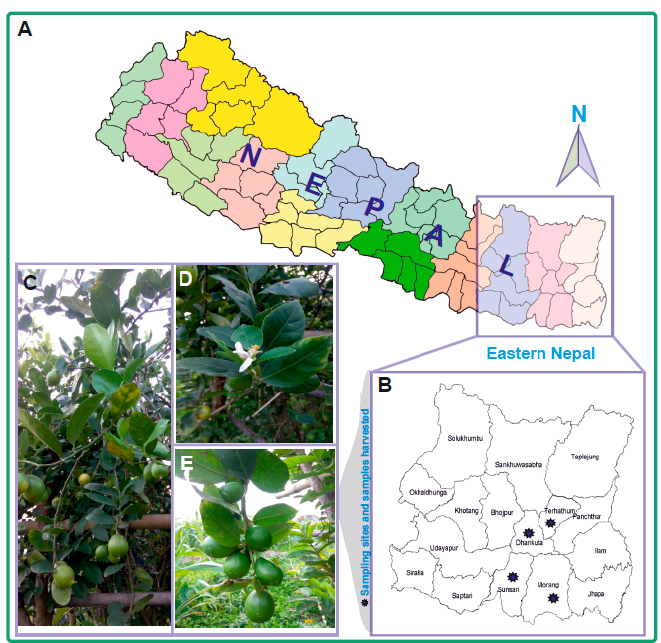
Figure 1. The sampling sites and acid lime pictures used for the experiment. ( A ) Map of Nepal; ( B ) sites from where the samples were harvested; ( C – E ) trees and branches from which the samples were harvested. Table 1. Altitudinal range, cultivar numbers, and locality details of the acid lime samples. Above 1200 m asL 600–1200 m asL Less Than 600 m asL Cult. No. Cult.